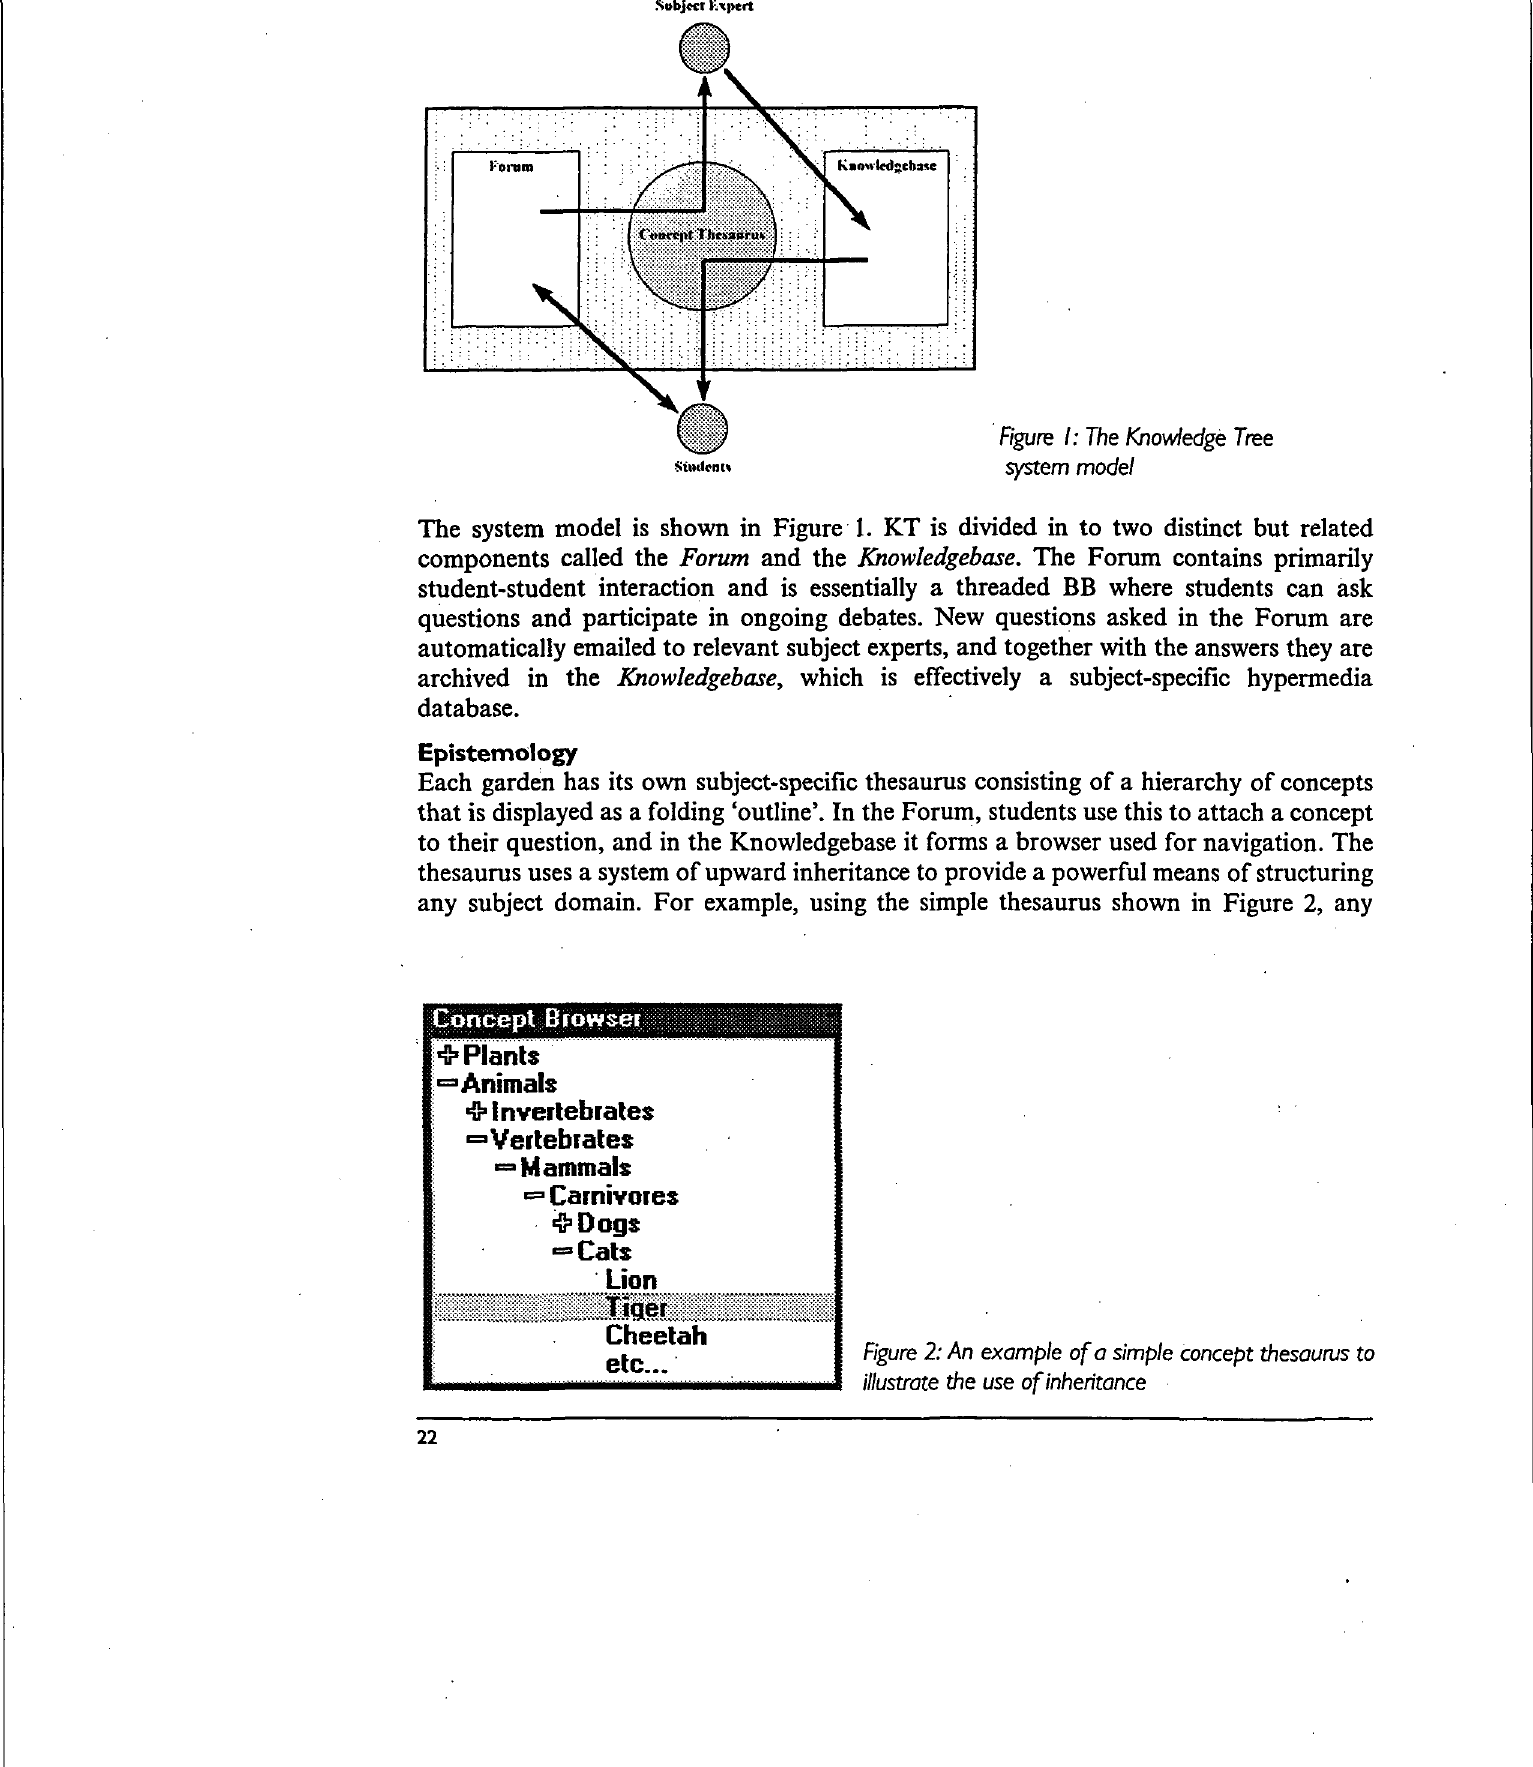
Figure 2: An example of a simple concept thesaurus to illustrate the use of